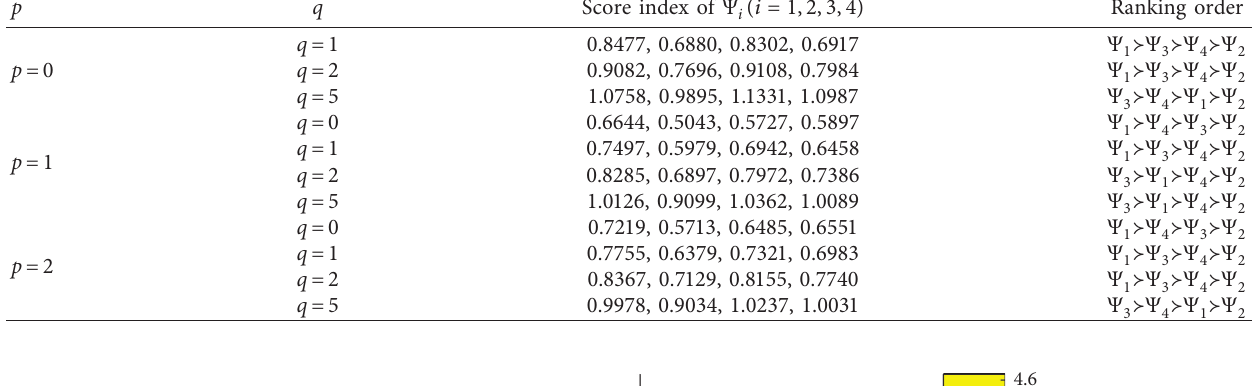
Table 6: The influence of parameter q on the rank of alternatives ( θ � 1 ) .